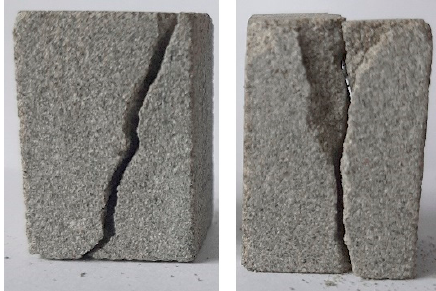
Figure 2. Typical failure patterns of samples.